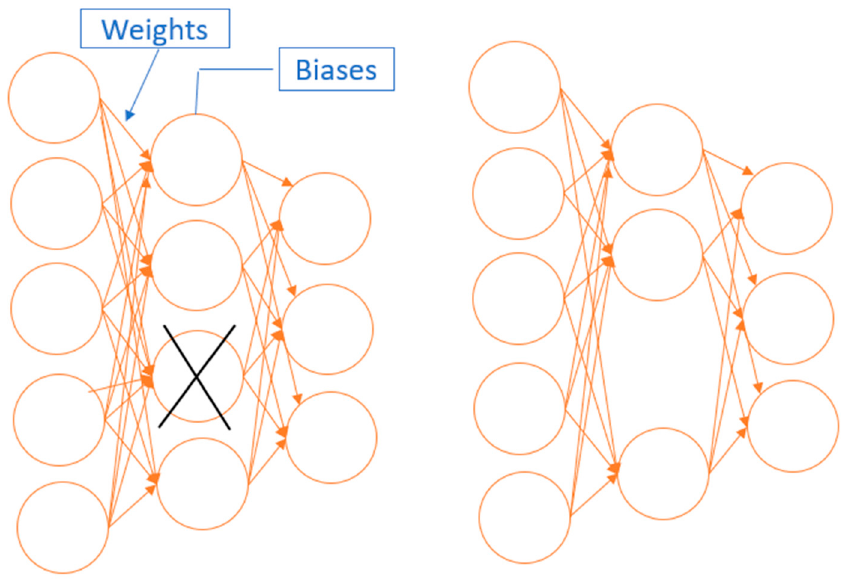
Figure 3. The idea of node pruning.